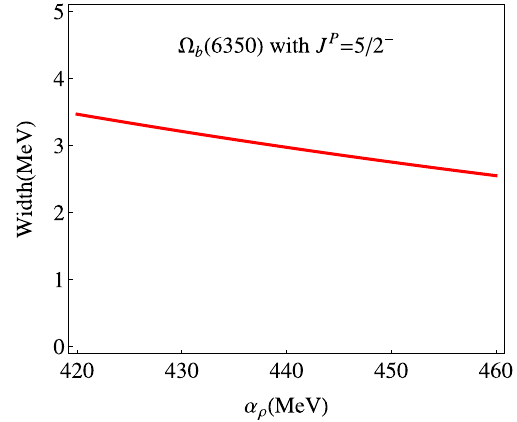
Fig. 4 The allowed mixing angle θ under the assignment of the ( 6316 ) − as J P = 1 / 2 − state. The red solid line is the | 1 P 1 / 2 − (cid:7) (cid:2) b state, and the blue dashed curve corresponds to the | 1 P 1 / 2 − (cid:7) 2 state. The green band stands for the measured total decay width with error